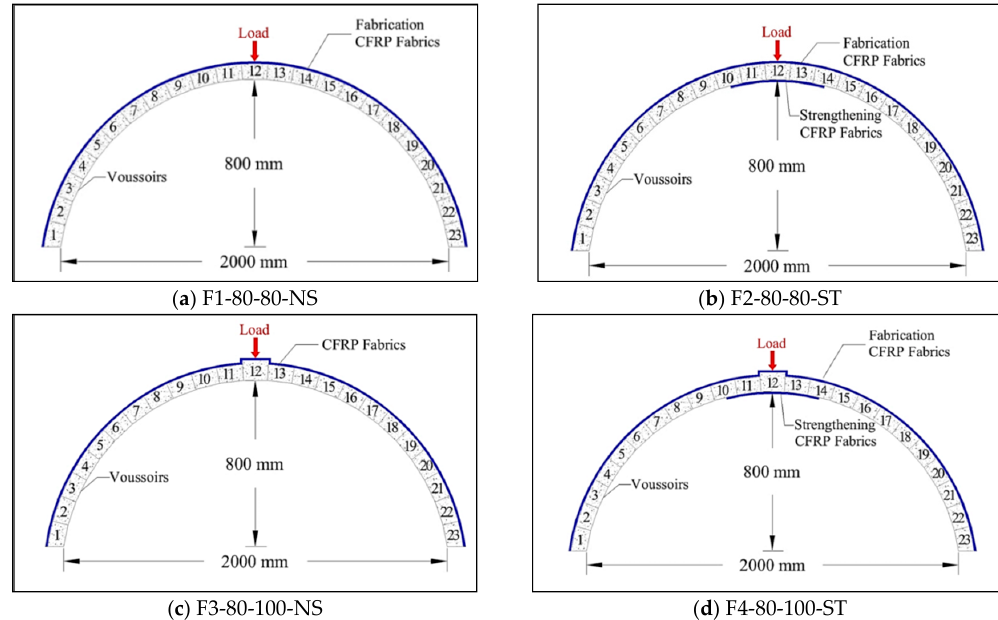
Figure 3. Experimental models of self-form segmental concrete masonry arches.